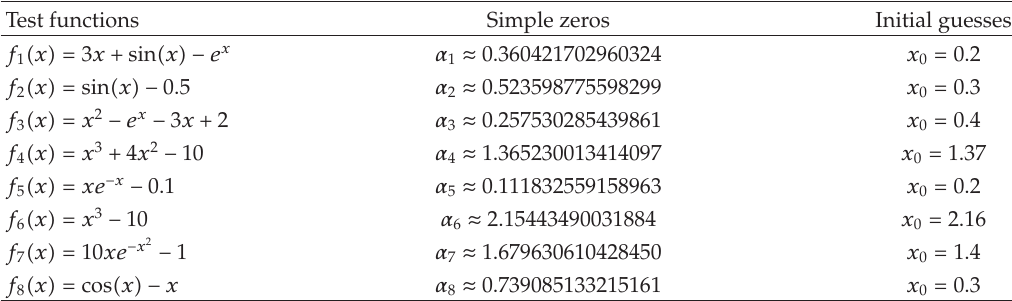
Table 2: The test functions considered in this study. Test functions Simple zeros Initial guesses